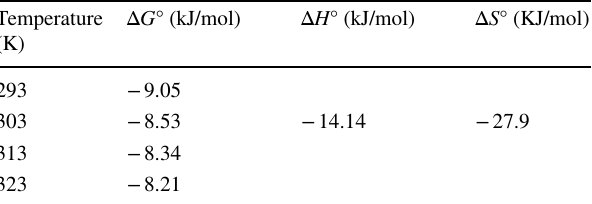
Fig. 7 The thermodynamic plot of ln K of MO onto Anchote peel adsorbent Table 3 Determined thermodynamic parameters for the adsorption of MO onto Anchote peel adsorbent